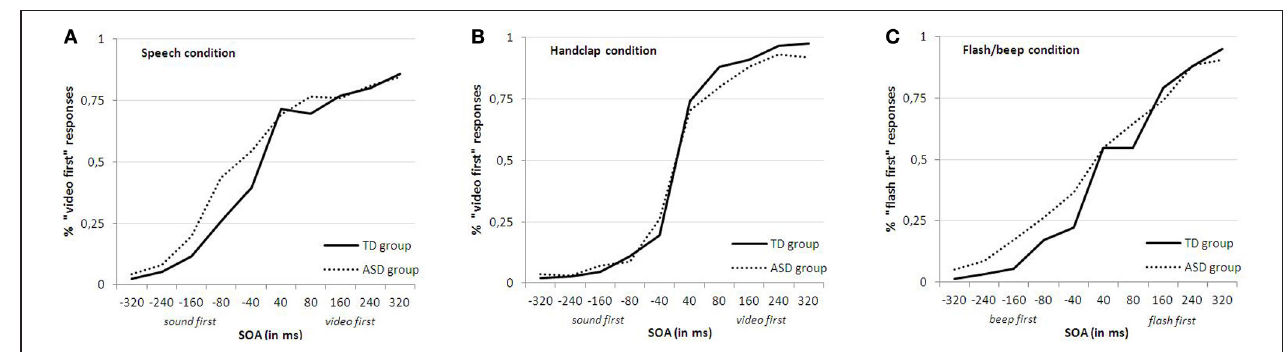
FIGURE 2 | Averaged raw data of both the TD and ASD group for each condition (“speech (A),” “handclap (B),” and “flash/beep (C)”).